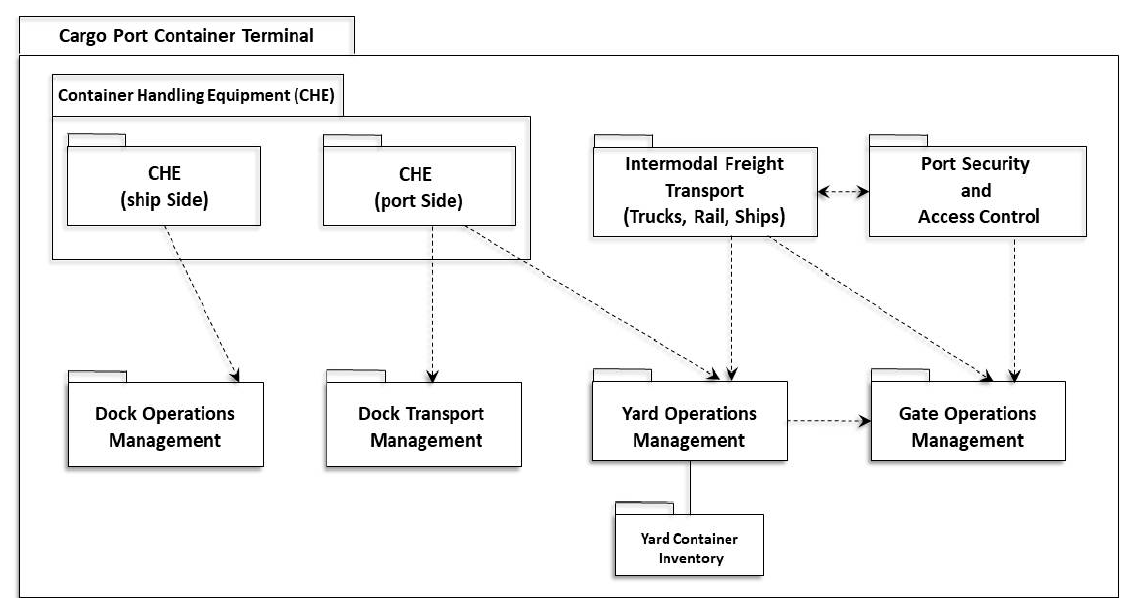
Figure 2. Cargo port system package diagram.